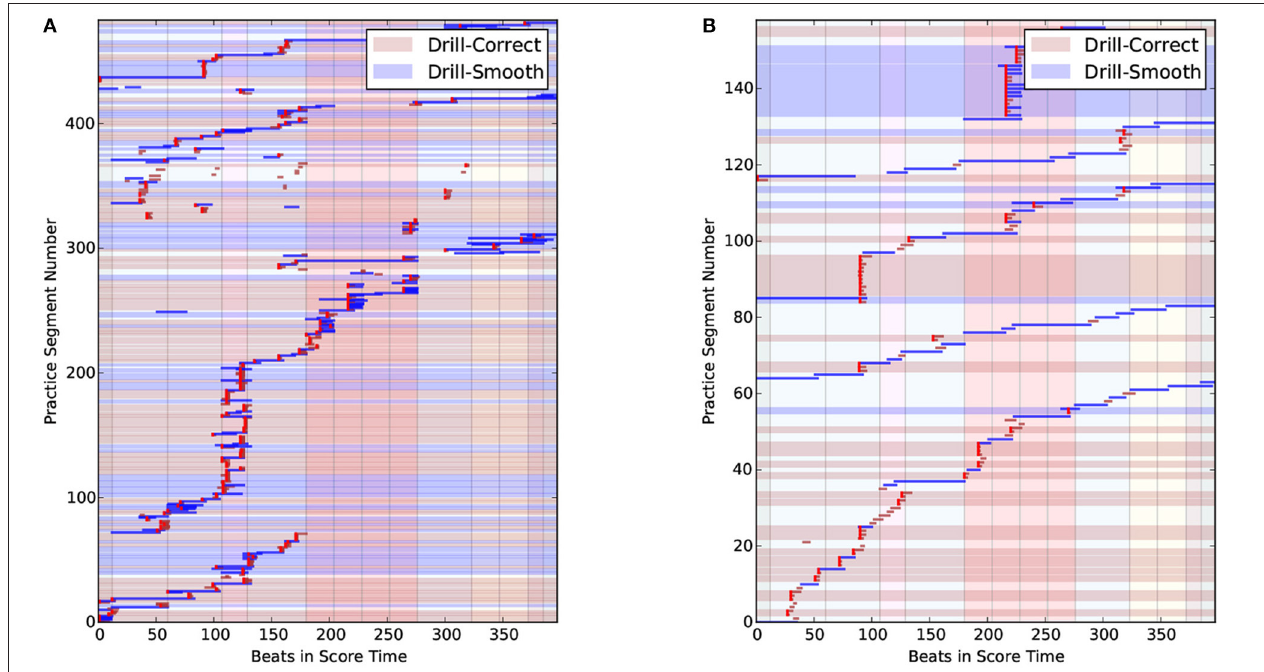
FIGURE 13 | Practice Session Work Maps for E-2 (Left) and I-2 (Right) showing Drill-Correct clusters (light brown background) and Drill-Smooth clusters (light blue background). (A) PSWM with drill clusters for E-2. (B) PSWM with drill clusters for I-2.